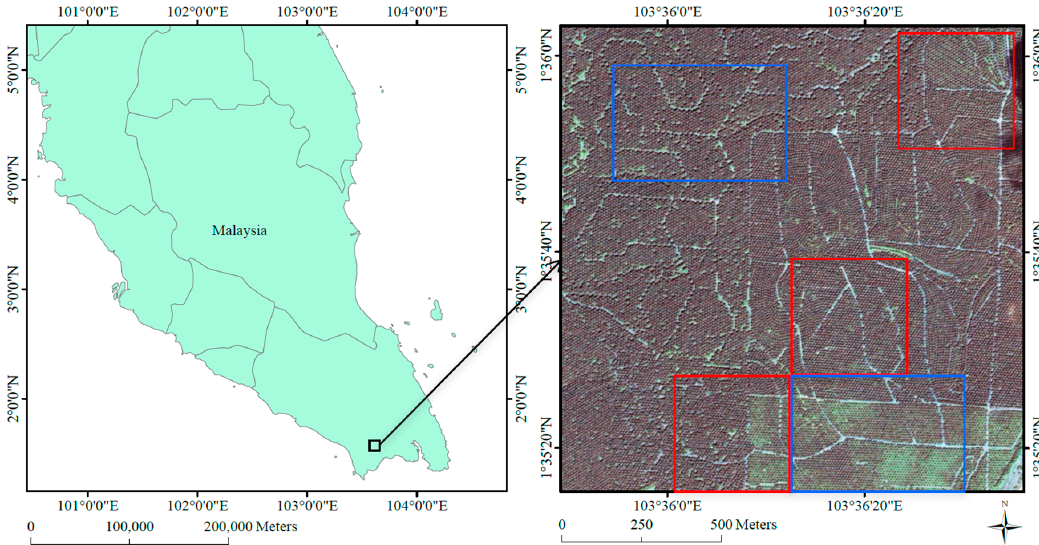
Figure 1. The study area of this research in the south of Peninsular Malaysia. The blue rectangles show the two regions from which the manually interpreted samples are collected. The red squares show the three selected regions for evaluating the performance of our proposed